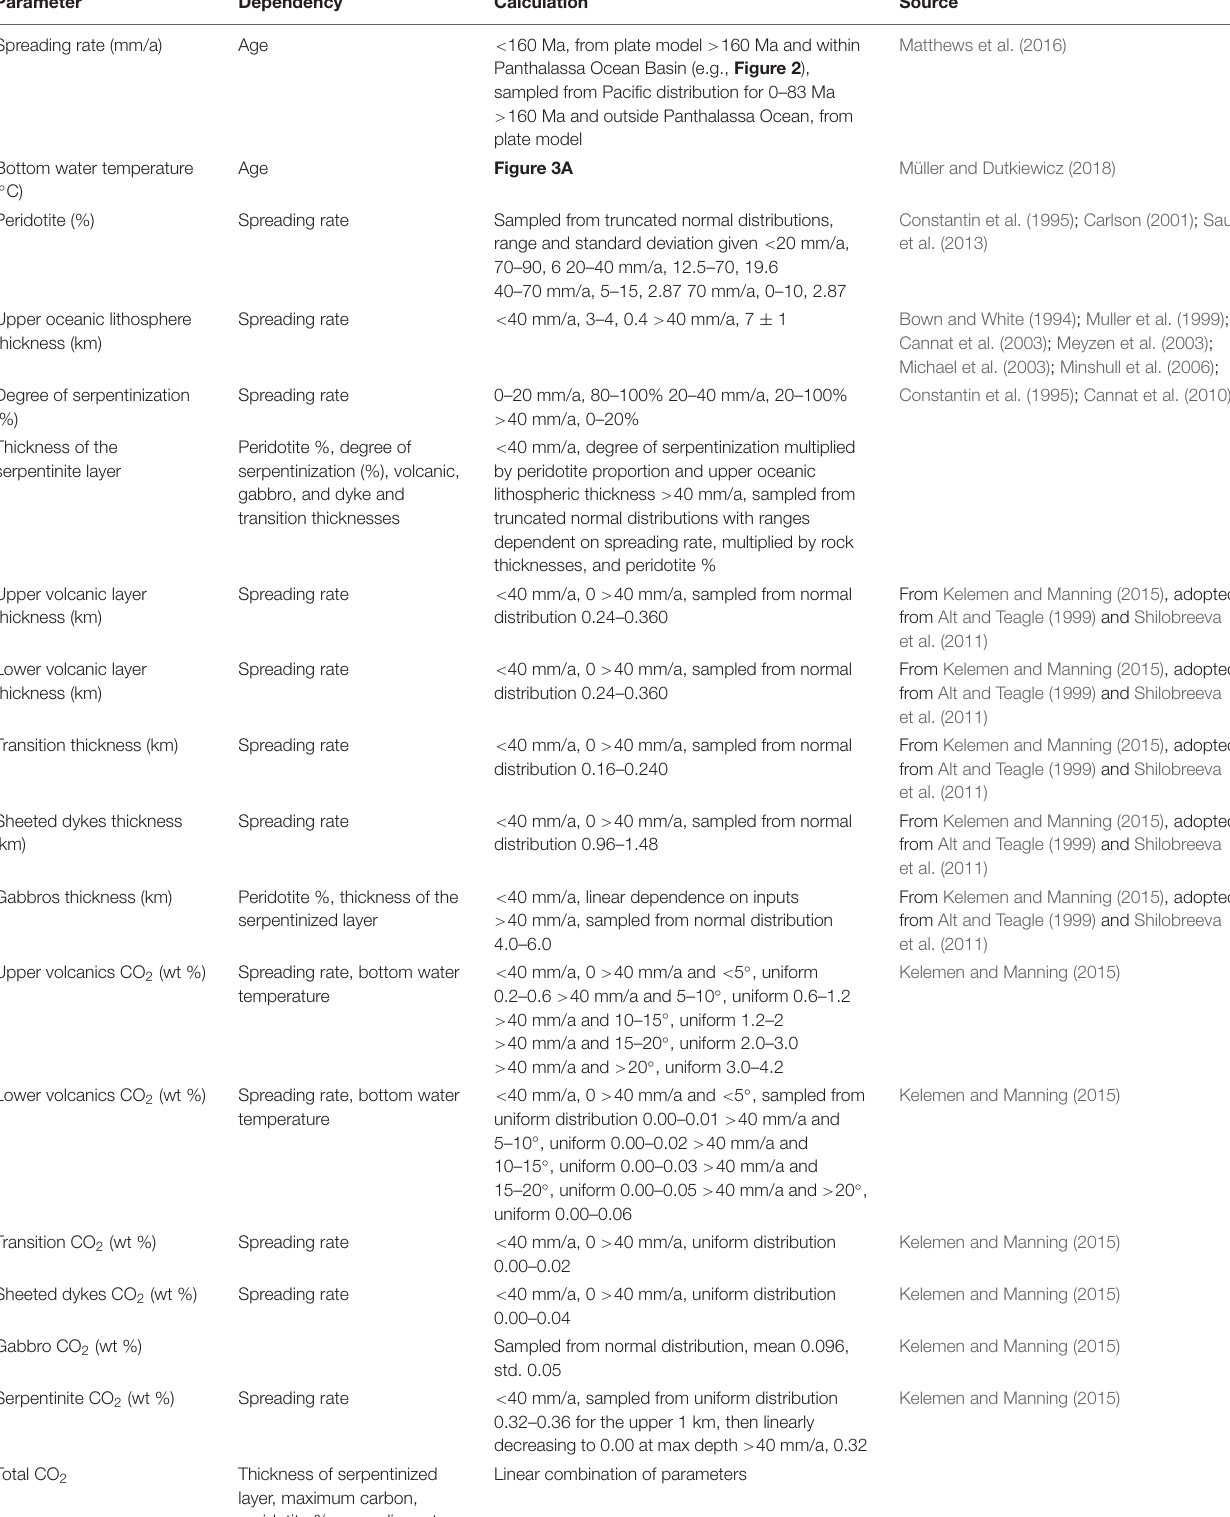
TABLE 1 | Parameter description, dependencies, and